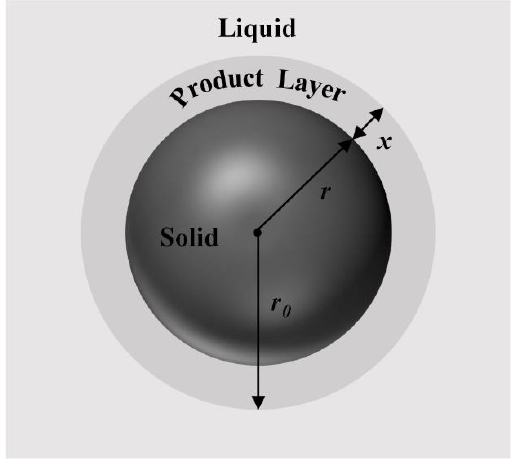
Figure 11. Schematic representation of the leaching of a spherical particle in bulk.